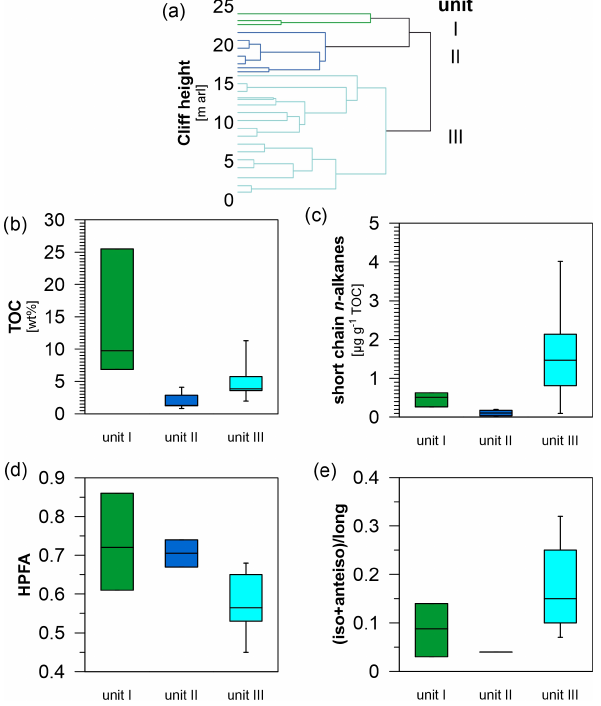
Figure 4. Statistical separation of the Sobo-Sise Yedoma cliff pro- file and selected carbon parameters of the separated cliff units. (a) Clustering of samples with y axis representing cliff height from the cliff top at 25m above river level (a.r.l.) to cliff bottom at 0ma.r.l. Unit I corresponds to Marine Isotope Stage (MIS) 1, unit II to MIS 2 and unit III to MIS 3. Resulting box plots allow better vi- sualisation of the OM distribution along the Sobo-Sise Yedoma cliff profile: (b) total organic carbon (TOC) content (in wt%), (c) short- chain n -alkane concentration (in µgg − 1 TOC), (d) higher plant fatty acid (HPFA) index, and (e) ratio of iso- and anteiso-branched sat- urated fatty acids (C 11 , C 13 , C 15 and C 17 ) to mid- and long-chain (C ≥ 21) n -fatty